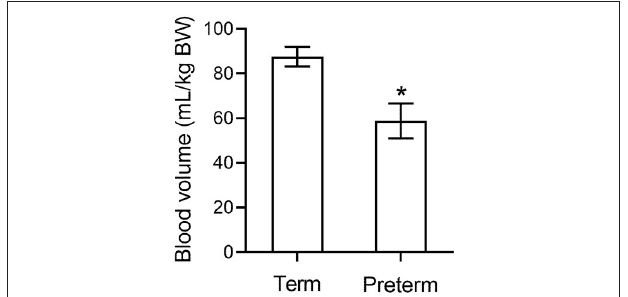
FIGURE 1 | Blood volume in preterm piglets ( n = 26) is significantly lower than in term piglets ( n = 3) (39). * indicates p < 0.001.